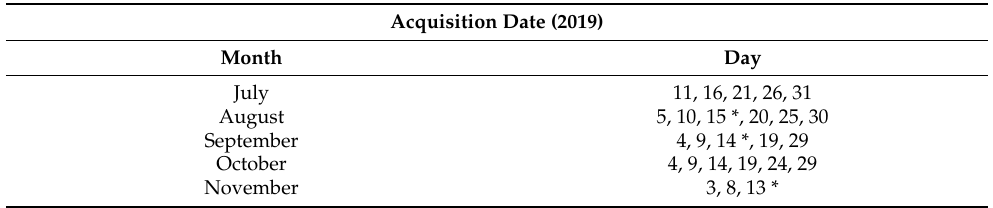
Table 4. Acquisition dates of Sentinel-2 satellite images used in the